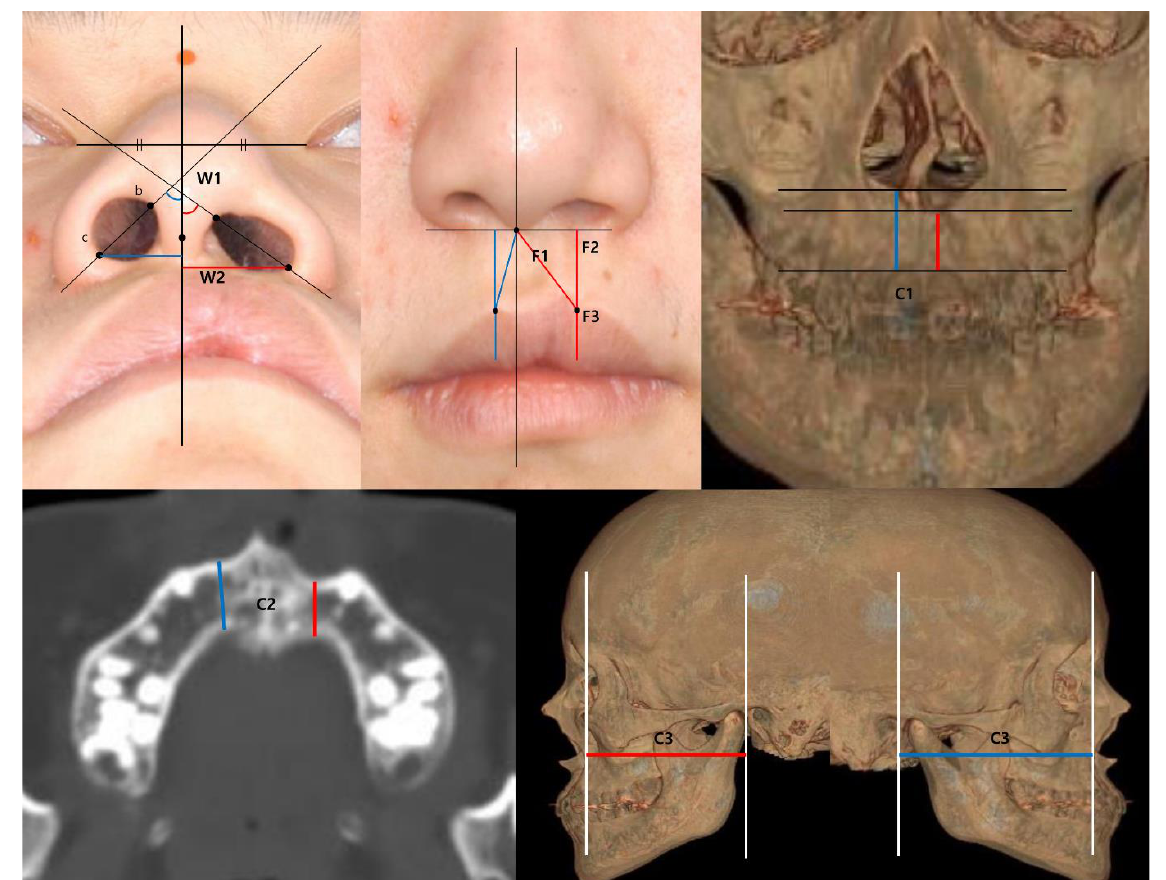
Figure 1. Anthropometric and three-dimensional analysis. ( upper, left ) Worm’s-eye view. W1, nostril angle; W2, width of the alar base. ( upper, center ) Frontal view. F1, philtral height; F2, lip height; F3, thickness of dry vermilion. ( upper, right ) Frontal view of the 3D reconstructed CT scan. C1, alveolar height. ( lower, left ) Axial cross-section of the alveolar process. C2, alveolar thickness. ( lower, right ) Lateral view of the 3D reconstructed CT scan. C3, paranasal hypoplasia.